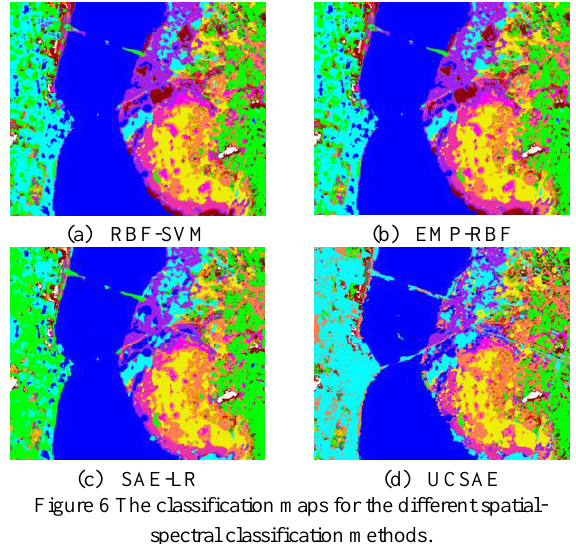
Figure 6 The classification maps for the different spatial- spectral classification